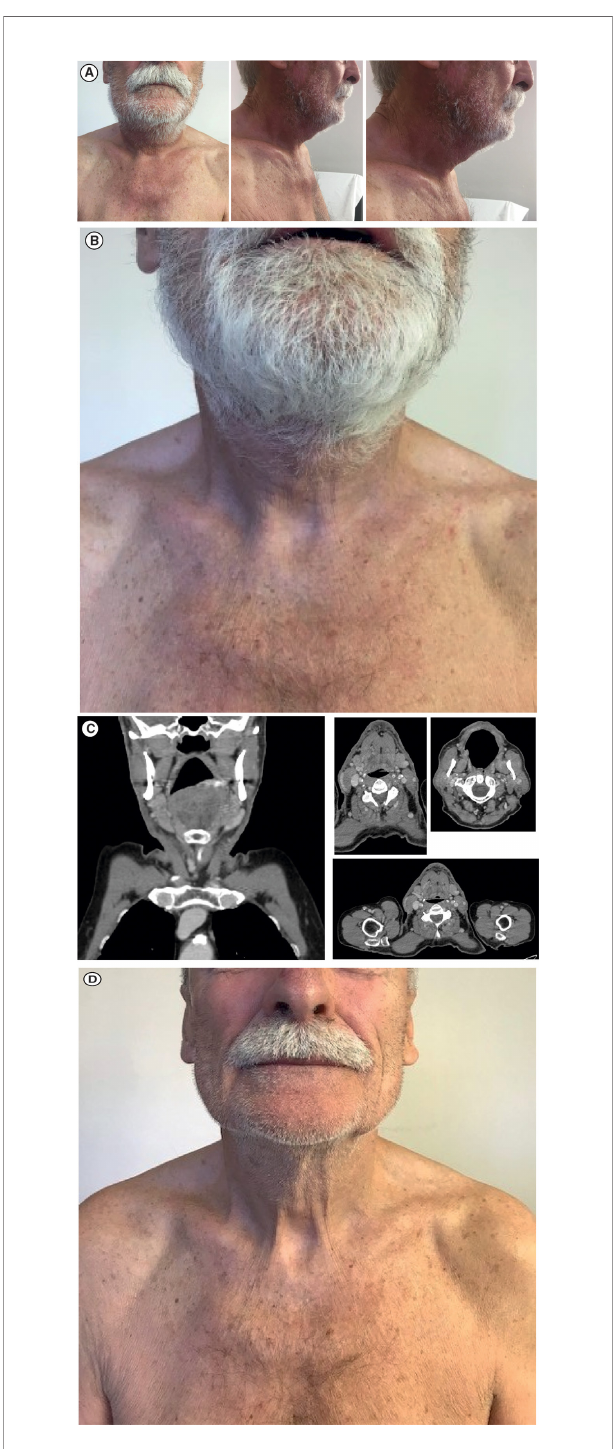
FIGURE 3 | Response to avelumab treatment: (A) Clinical presentation of substantial measurable reduction in lesion size after one dose of avelumab. (B) Clinical presentation of con fi rmed complete regression of the tumor mass after three doses of avelumab. (C) Face and neck coronal (leftmost panel) and axial (right panels) CT scans showing complete radiological response. (D) Clinical presentation of ongoing complete response on 30 October 2019. CT, computed tomography.